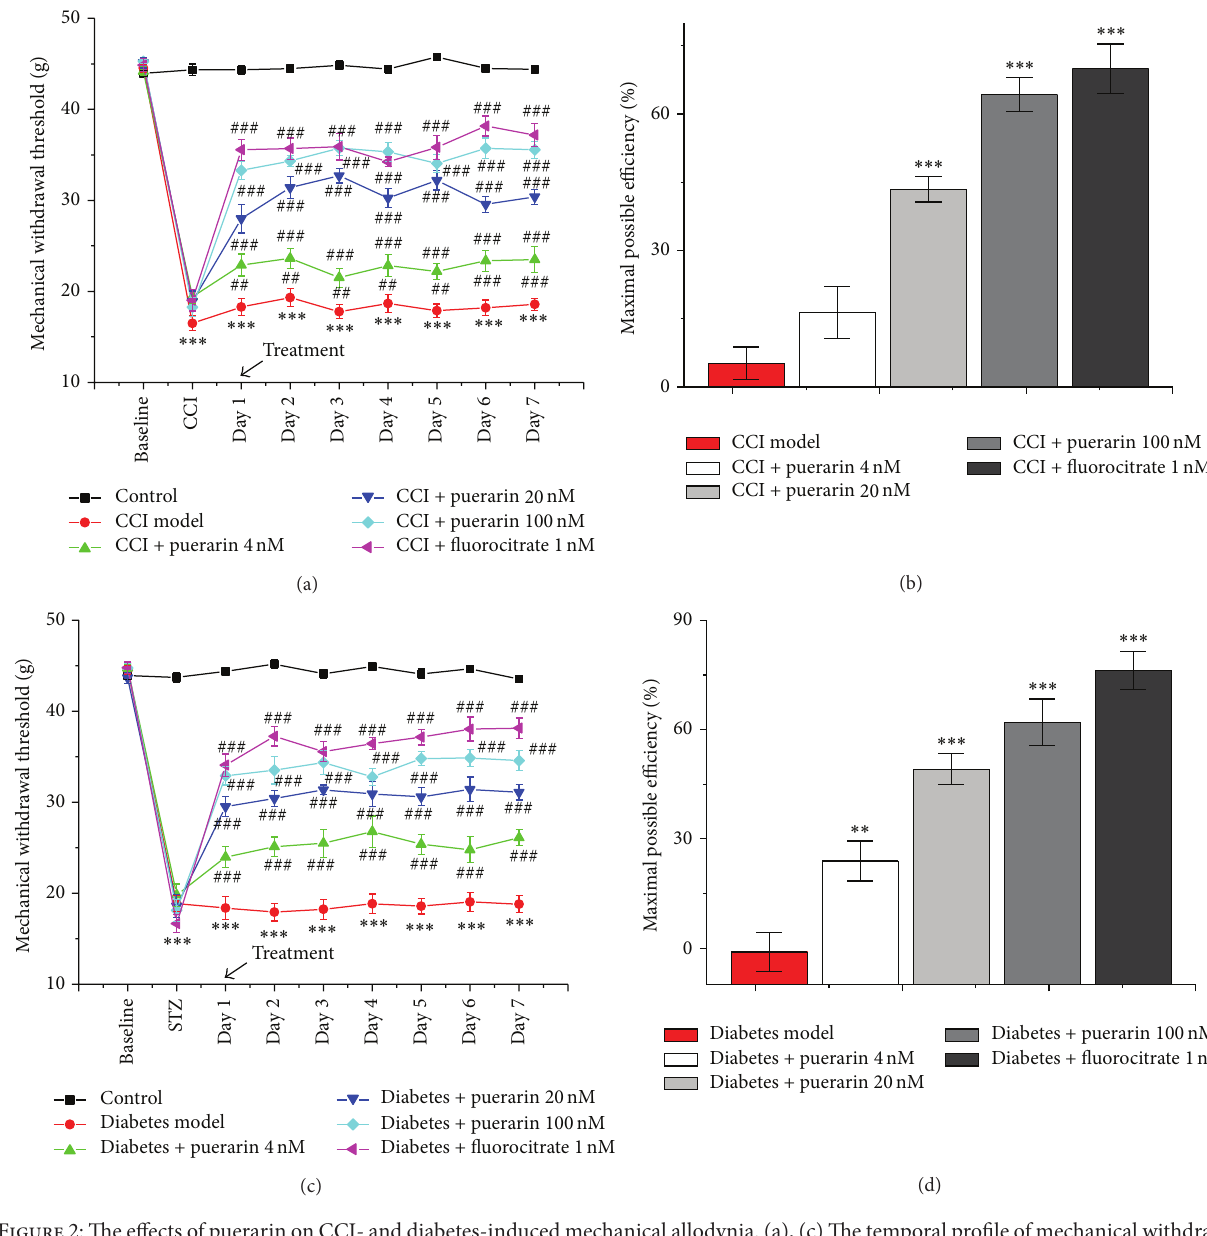
Figure 2: The effects of puerarin on CCI- and diabetes-induced mechanical allodynia. (a), (c) The temporal profile of mechanical withdrawal threshold on CCI- (a) and diabetes- (c) induced mechanical allodynia; (b), (d) the maximal possible efficiency of puerarin on the 11th day after CCI surgery (b) and the 27th day after streptozotocin injection; CCI: chronic constriction injury. Data are presented as mean ± SEM. ∗∗∗ 𝑃 < 0.001 , model group versus control group; # 𝑃 < 0.05 , ## 𝑃 < 0.01 , ### 𝑃 < 0.001 , puerarin treatment group versus model group (one-way ANOVA with post hoc LSD 𝑡 -test). Each group consisted of 6–10